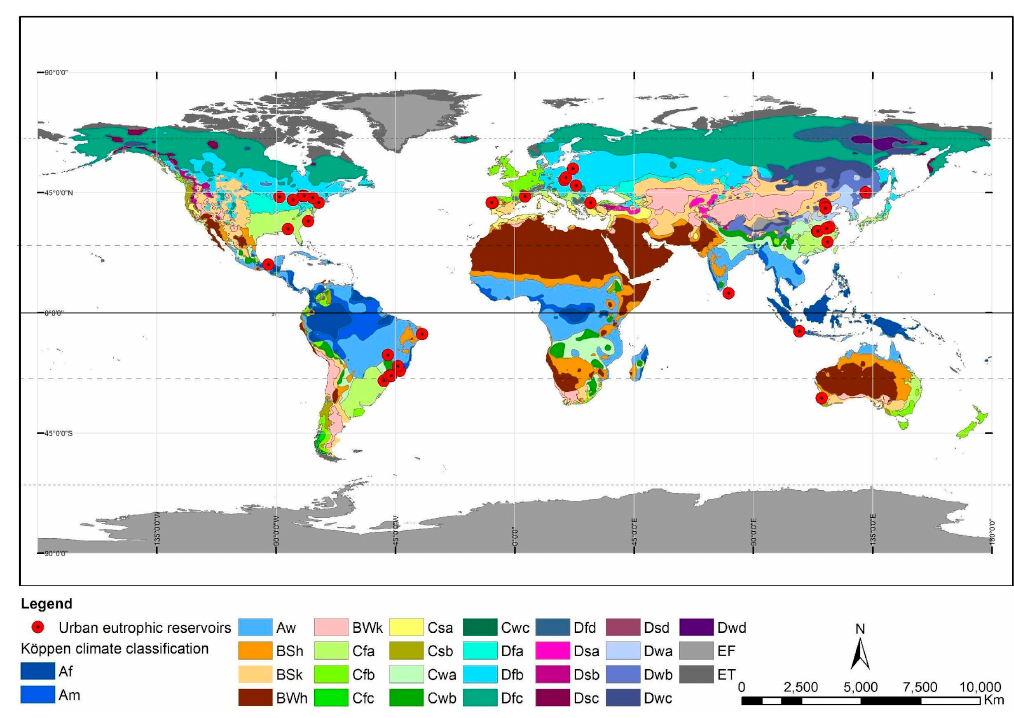
Figure 3. Spatial distribution of studies and climatic classification of Koppen-Geiger.